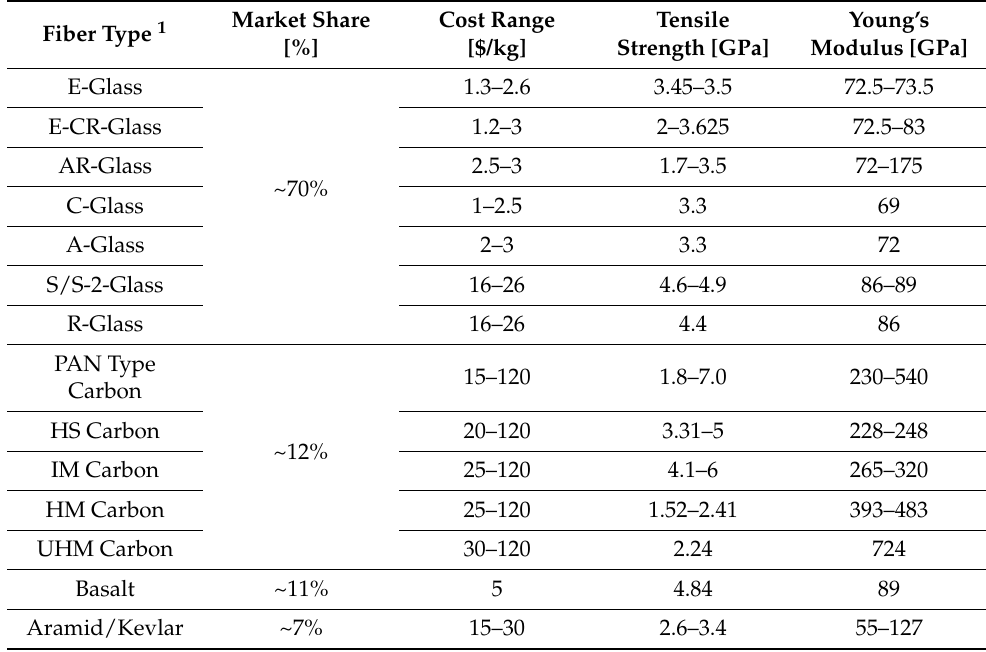
Table 1. Reinforcement comparison by fiber type, i.e., glass, carbon, basalt, aramid, and their market share, cost range and mechanical properties